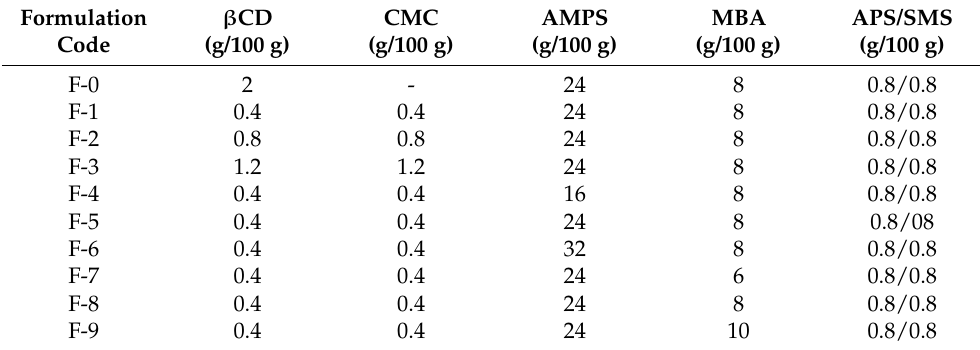
Table 5. Composition of β CD-CMC-g-poly (AMPS) Nanosponges.